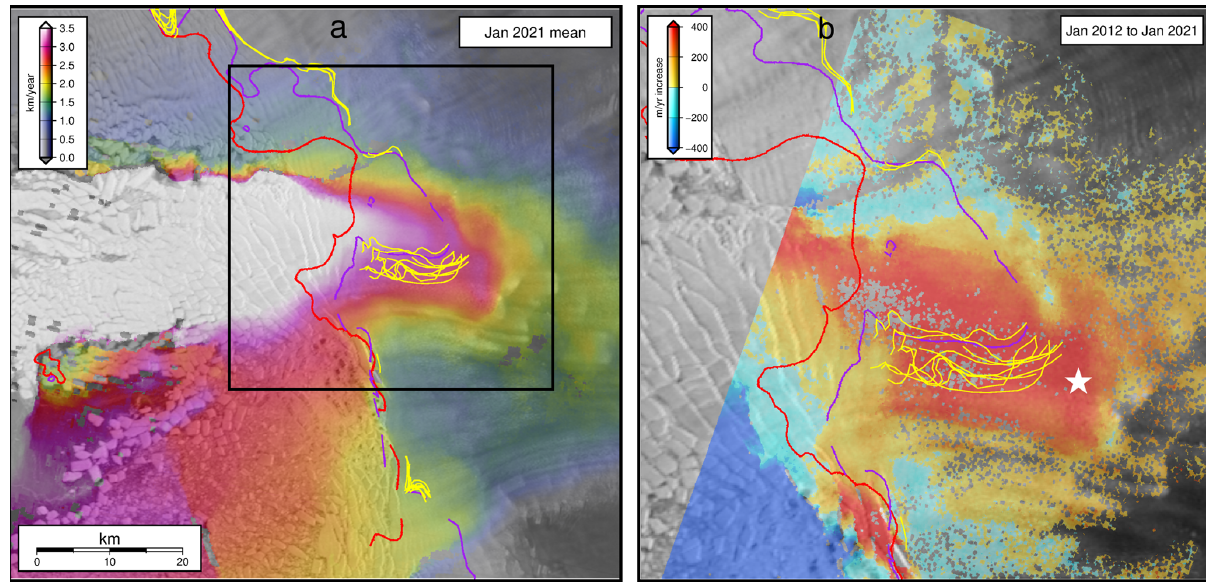
Figure A2. (a) Mean surface speeds for January 2021 based on feature tracking Sentinel-1 data. (b) Change in surface speed from January 2012 based on feature tracking TerraSAR-X data to January 2021 speeds. The white star marks the velocity extraction